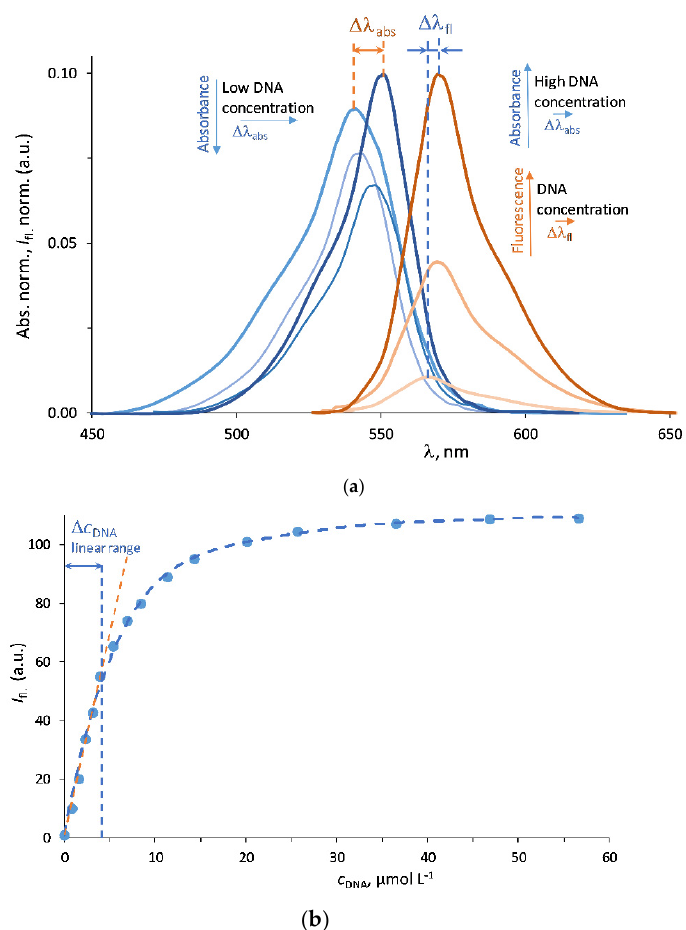
Figure 4. ( a ) Changes in the absorption and fluorescence spectra of trimethine cyanine 1 (Cyan 2) upon titration of its buffer solution with a concentrated DNA solution. Evolution of the absorption spectrum: at low DNA concentrations, a decrease in the absorption band is observed due to partial aggregation of the dye on DNA; at moderate DNA concentrations, a bathochromic shift of the band is observed due to decomposition of the aggregates formed and binding of the monomeric dye to DNA; and at high DNA concentrations, an increase in a longer ‐ wavelength band is observed due to accumulation of the complex of the monomeric dye with DNA. A growth of the fluorescence band is observed in parallel with the formation of the complex. ( b ) Increase in the fluorescence intensity of trimethine cyanine 1 (Cyan 2) upon titration of its buffer solution with a concentrated DNA solu ‐ tion.